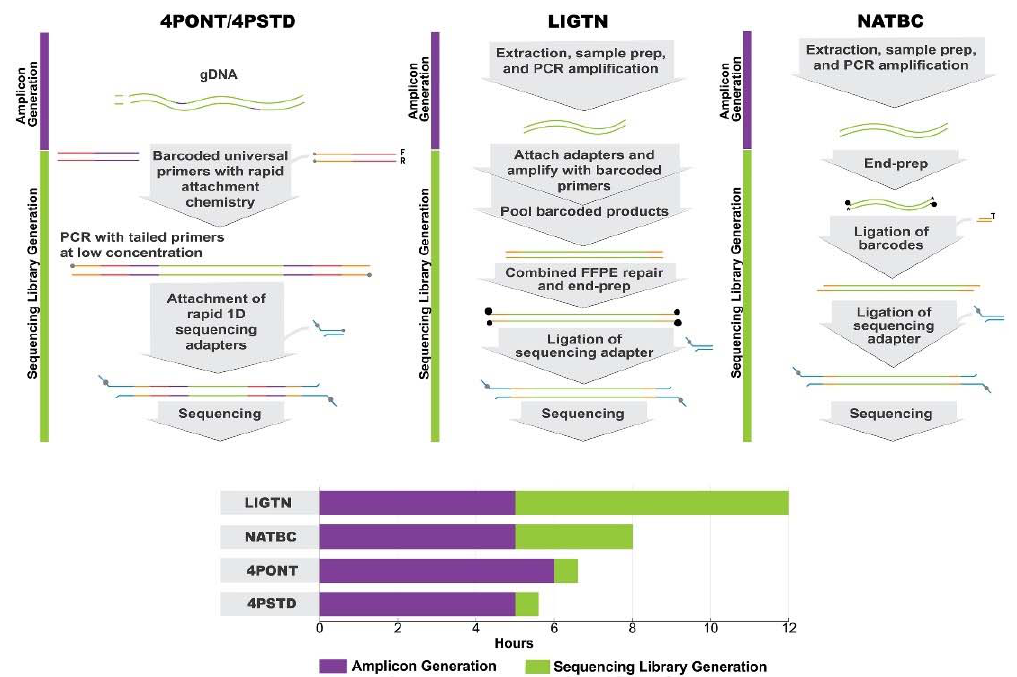
Figure 1. ONT Library Preparation Workflows. Generalized workflow for the four Oxford Nanopore Technology library preparation methods tested. Note that the 4-Primer method covers both the 4PSTD and 4PONT methods, the difference being the PCR cycling parameters. The bar chart displays total time from extracted gDNA to loading onto an ONT flow cell and broken down by the two primary processes: “Amplicon Generation” and “Sequencing Library Generation”: Amplicon Generation includes all steps from gDNA to PCR product, and Sequencing Library Generation includes all steps from PCR product to loading an ONT flow cell. Table 2. Organism ID and strain information for PCR assay targets. Organism ID and strain information, along with which PCR assays are expected to amplify are shown, totaling 20 unique assays (PCR primer pairs). There are 3 assays specific for Variola virus included in the 23-plex but not shown in the table because these were not expected to amplify any of the test